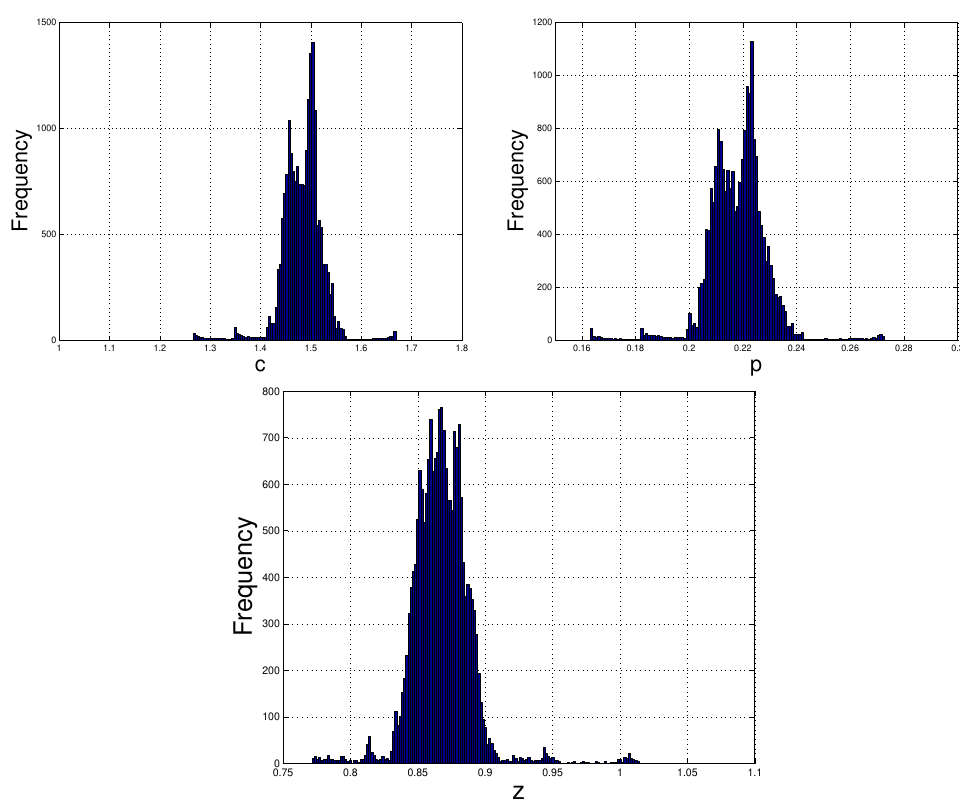
Figure 20. Histograms of system (12) with the parameters chosen from Figure 19.